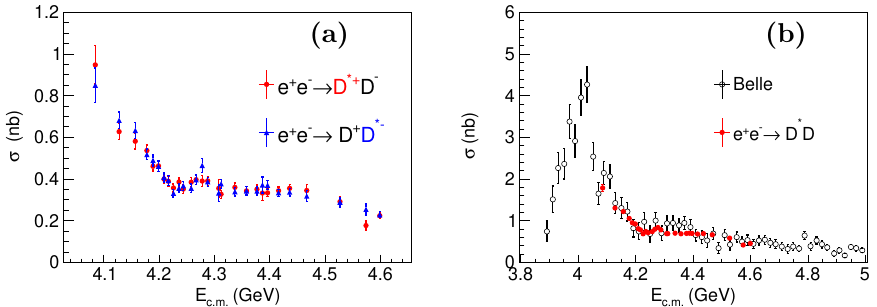
Figure 5. (a) The Born cross sections of the reaction channel e + e − → D ∗ + D − for the recon- structed D ∗ + candidates (red dots) and e + e − → D + D ∗− for the reconstructed D ∗− candidates (blue triangles) as functions of the c.m. energy. (b) The comparison of the combined cross sections for e + e − → D ∗ + D − + c.c. between this work (red dots) and those of the Belle experiment [21] (black circles). Error bars are the quadratic sum of statistical and systematic